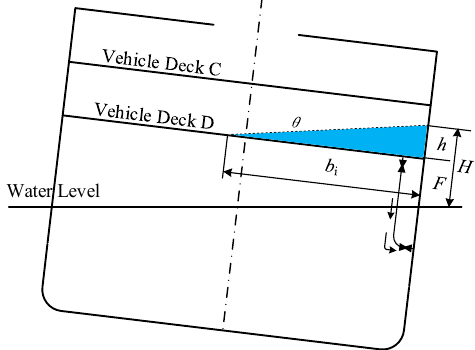
Figure 3. Firewater accumulated on the starboard side.